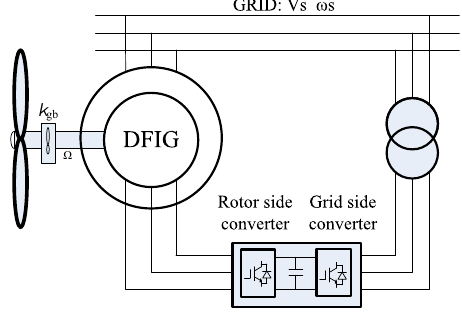
Figure 2. Schematic diagram of doubly fed induction generator (DFIG) based wind energy conversion